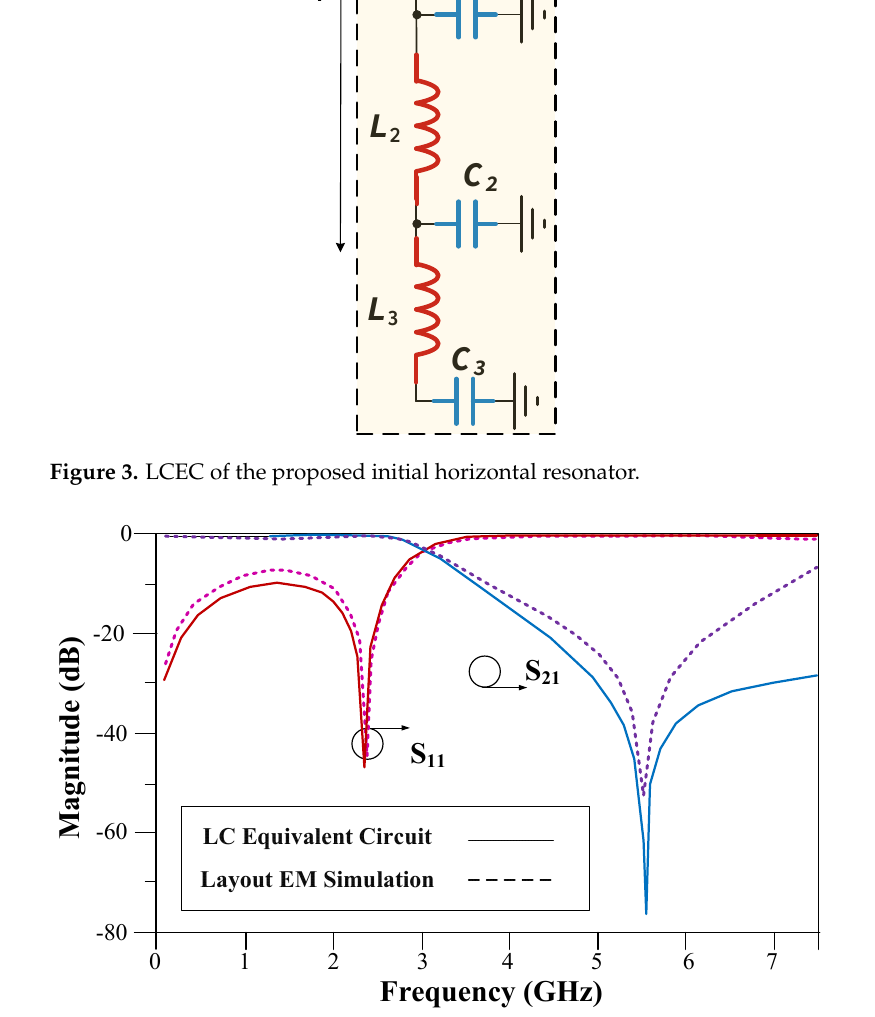
Figure 4. Frequency response of the presented LC circuit, as compared with the frequency response of the layout transmission line realization.